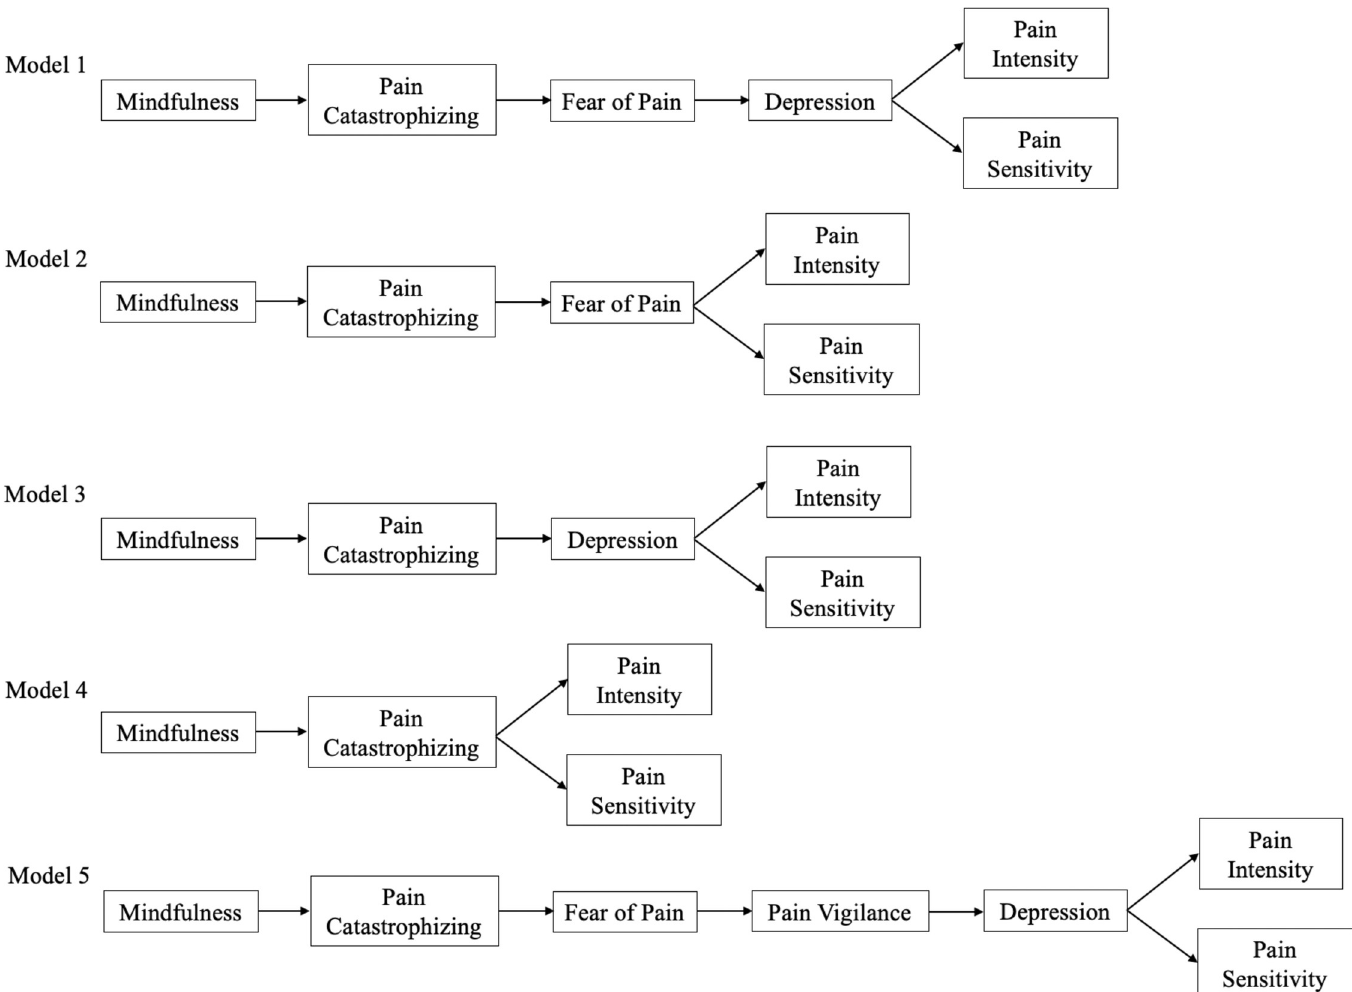
Fig 1. Structural equation models tested in Studies 1 and